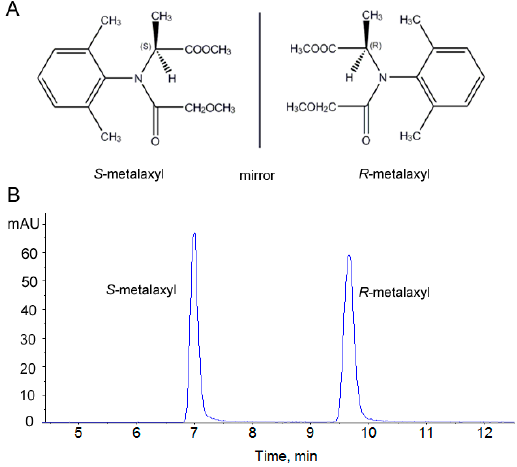
Figure 1. Chemical structure ( A ) and representative chromatogram ( B ) of metalaxyl